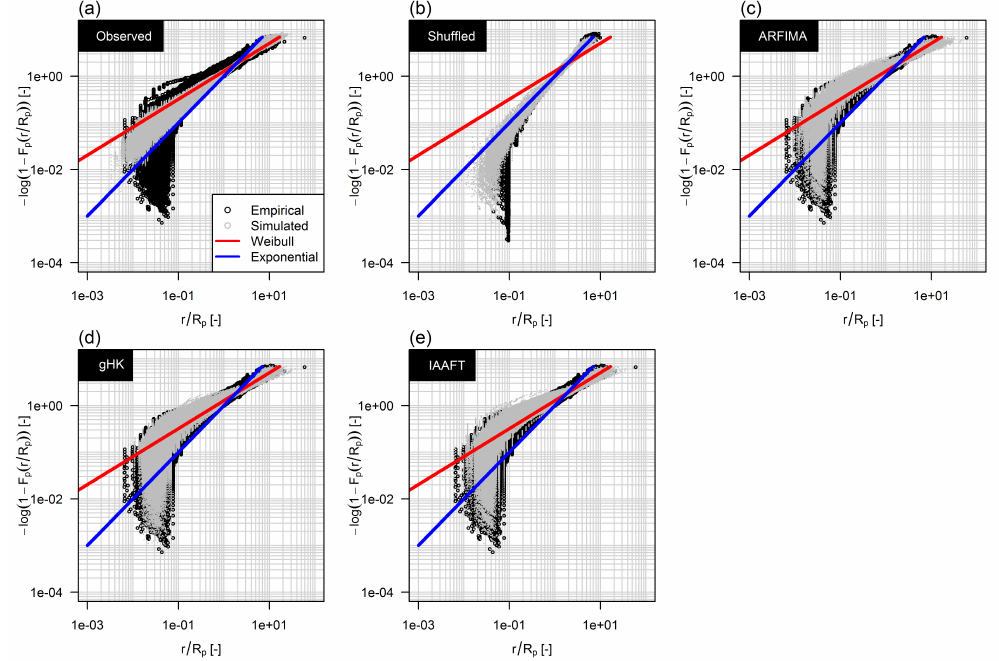
Figure 10. Survival functions of the standardized return intervals between standardized flow values exceeding the 95% quantile threshold. The axis scales highligth the linear patterns of the exponential and Weibull distributions making the comparison with the empirical functions easier. In all panels but ( b ), black circles indicate the survival functions corresponding to the observed series. In panel ( b ) black circles indicate the survival functions corresponding to the observed shuffled (uncorrelated) data. Grey circles denote survival functions resulting from simulation by Weibull distribution ( a ); standard exponential distribution ( b ); ARFIMA ( c ); gHK ( d ); and IAAFT ( e ). Each panel also shows theroretical standard exponential distribution (blue line) and Weibull distribution (red line) with shape parameter equal to the average value of H computed by